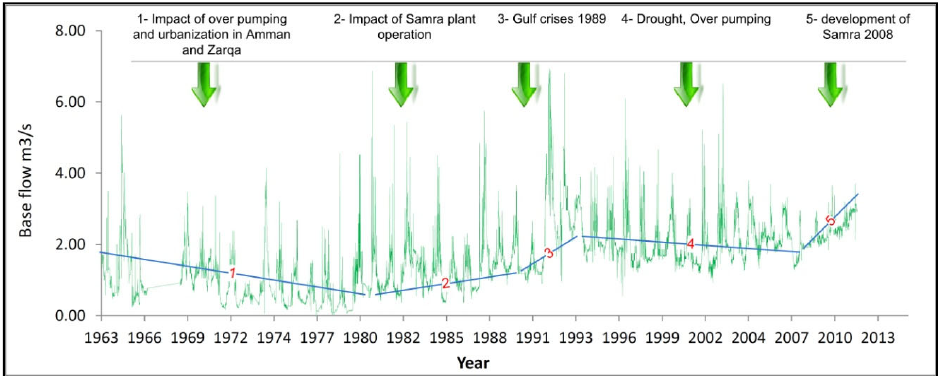
Figure 4. Long ‐ term record of base flow in Zarqa River. Figure 4. Long-term record of base flow in Zarqa